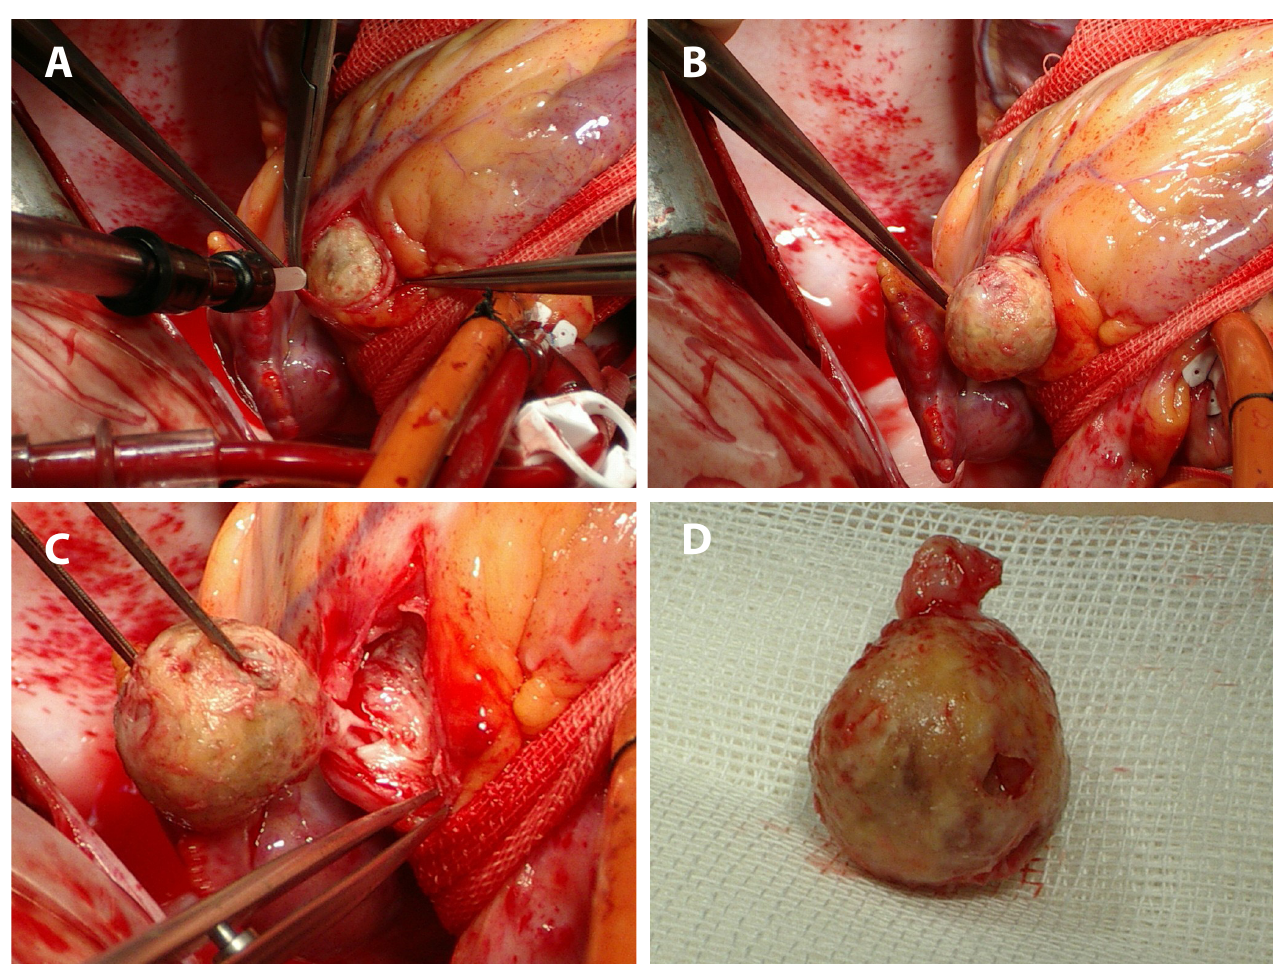
Fig. 3 – A: Perioperative view of the intracoronary hydatid cyst prior to enucleation (Size: 2x2 cm). B: Perioperative view of the intracoronary hydatid cyst, distally liberated but proximal attachment is intact. C: Perioperative view of the intracoronary hydatid cyst with proximal attachment (inferiorly located) intact. D: Enucleated intracoronary hydatid cyst, proximal attachment placed superiorly (size: 2x2